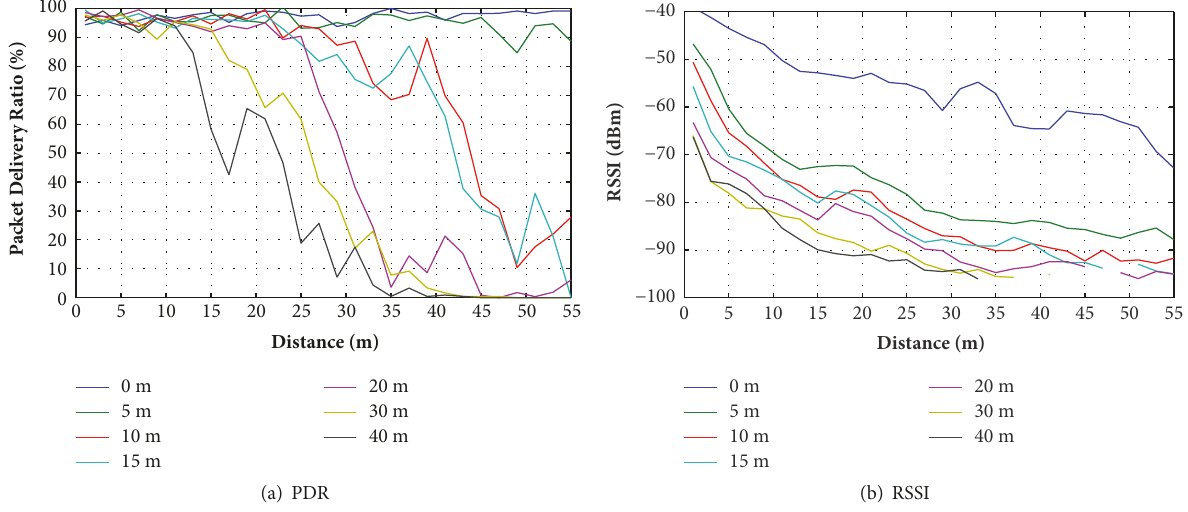
Figure 11: Results from real experiments for Electrical Engineering Lab. (a) PDR. (b) RSSI.